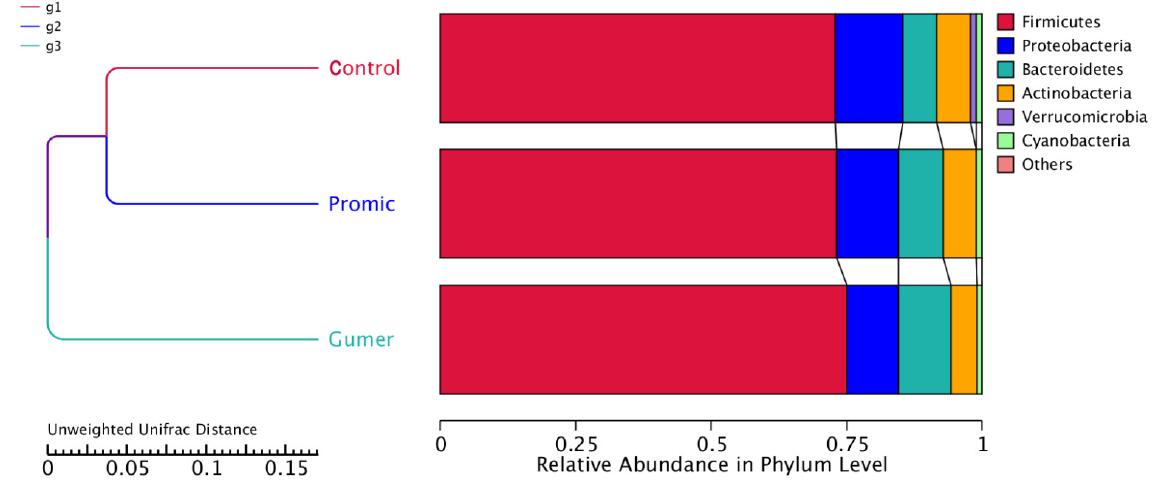
Figure 4. UPGMA cluster tree of the phylum level based on unweighted UniFrac distance.